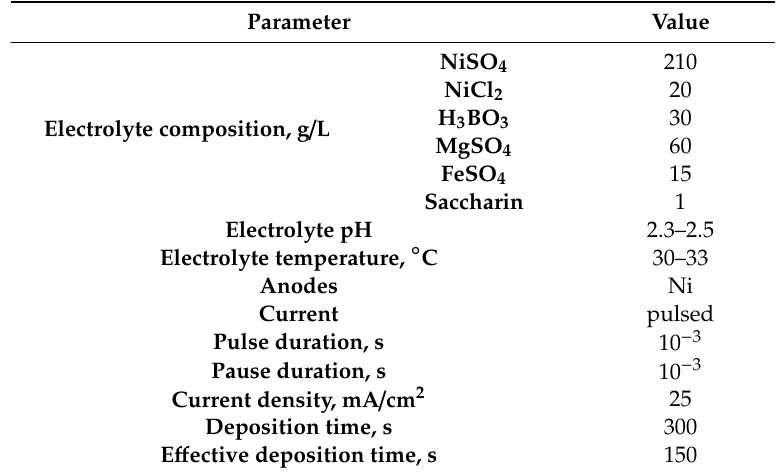
Table 1. Technological parameter of the electrodeposition of the NiFe